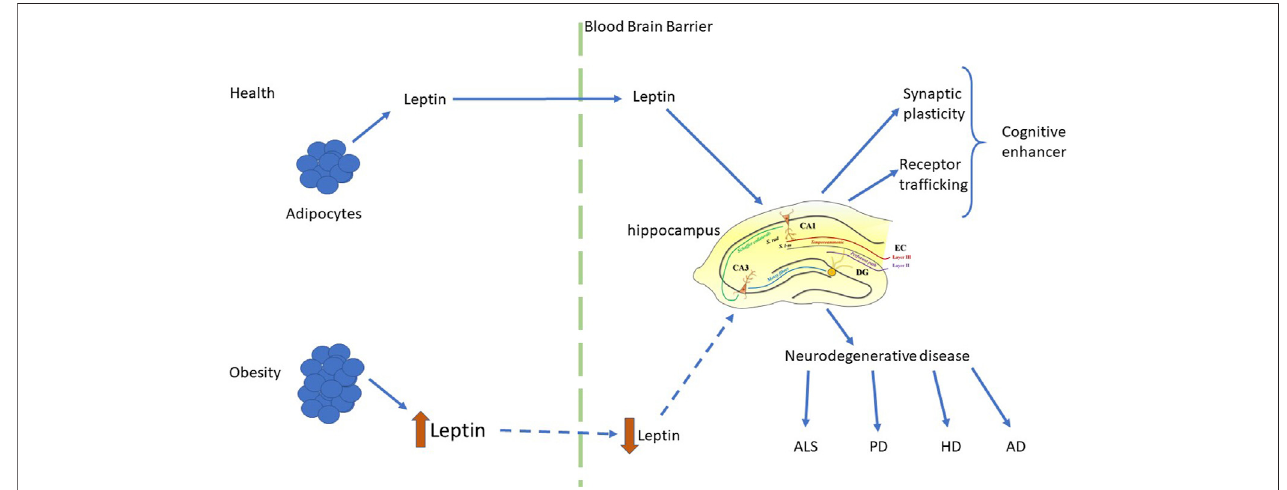
FIGURE 2 | Regulation of hippocampal function by leptin in health and disease. Schematic representation of the key synaptic effects of leptin and the functional consequences of leptin-driven alterations in hippocampal function. In health, physiological levels of leptin are released from adipocytes and readily cross the blood brain barrier to reach the brain. Within the hippocampus, leptin has pro-cognitive actions via its ability to rapidly modulate hippocampal synaptic plasticity and glutamate receptor traf fi cking. In contrast, in the obese state leptin levels are elevated, leading to development of leptin resistance, and reduced transport of leptin into the brain. This subsequently leads to dysfunctions in the ability of leptin to regulate hippocampal synaptic function, which is associated with an increased risk of neurodegenerative disorders, such as AD, HD, ALS and PD.